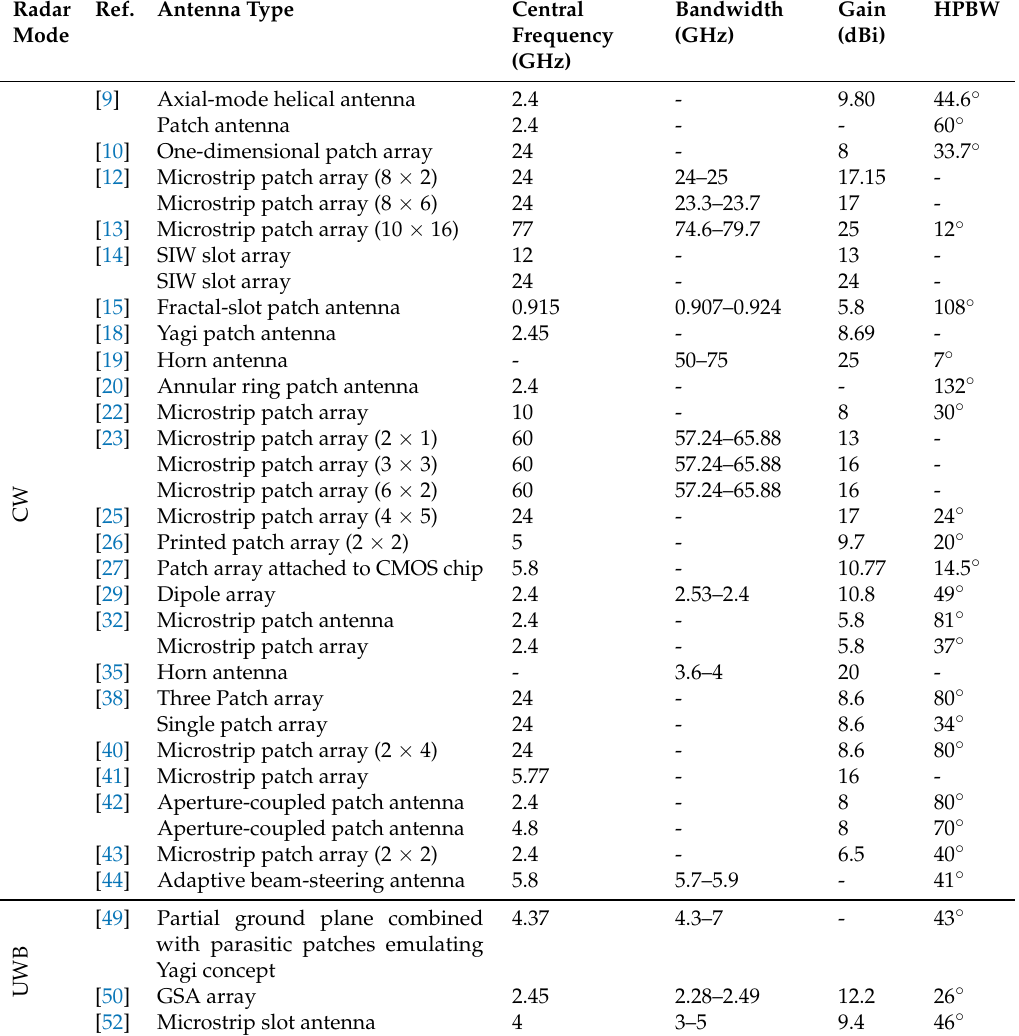
Table 2. Summary of the parameters of the reviewed